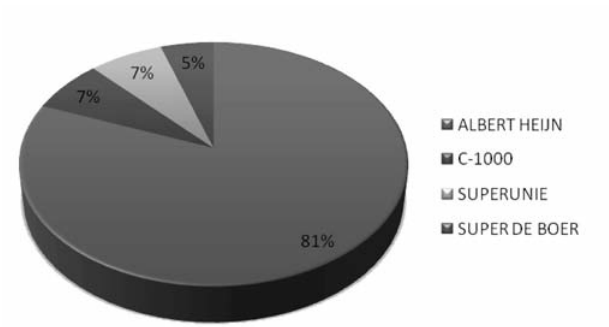
Figure 11 Supermarket Sell frozen vegetables in 2010 (value) Source: PT / Nielsen